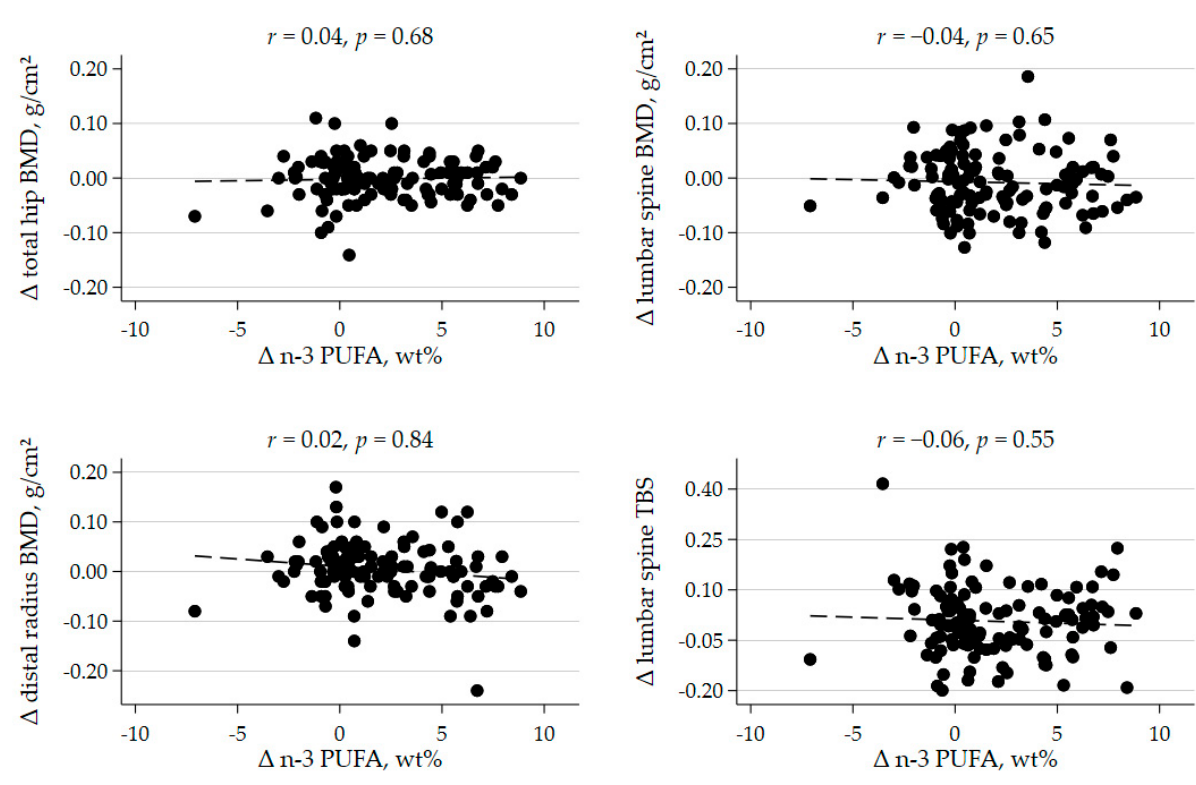
Figure 2. Scatterplots of the correlation between change in plasma marine n-3 polyunsaturated fatty acid (n-3 PUFA) concentration and change in bone mineral density (BMD) and trabecular bone score (TBS) after 44 weeks, r = Pearson’s correlation coefficient, with corresponding p value.